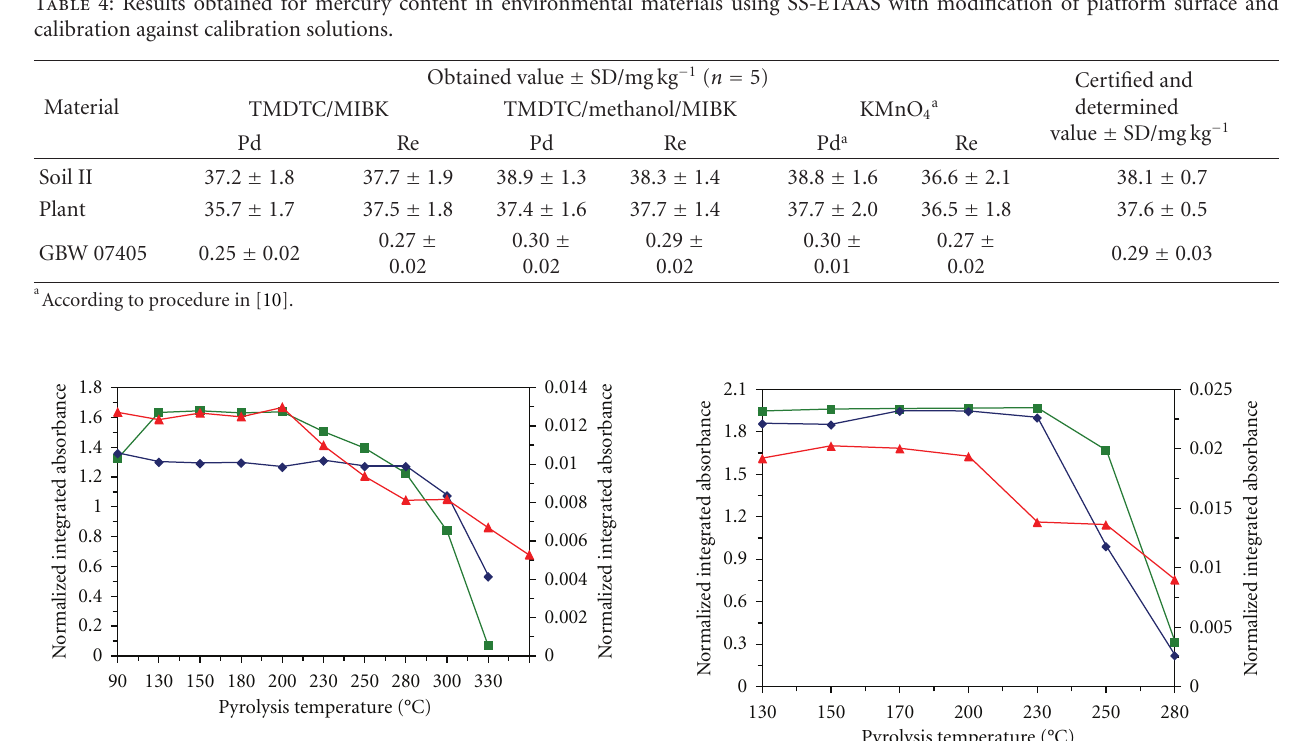
Hg ( n = 5) with the Re modifier. Calibration curves were linear to 15 ng Hg ( R 2 = 0 . 9991 for the Pd modifier and R 2 = 0 . 9998 for Re modifier). By using the Pd modifier, the detection limit, 120 pg Hg, was acquired from 10 repetitive firings of platform with KMnO 4 and enabled determination of 0.40 mg kg − 1 Hg for an optimum sample mass of 0.3 mg. By using the Re modifier, the detection limit was 110 pg Hg and 0.37 mg kg − 1